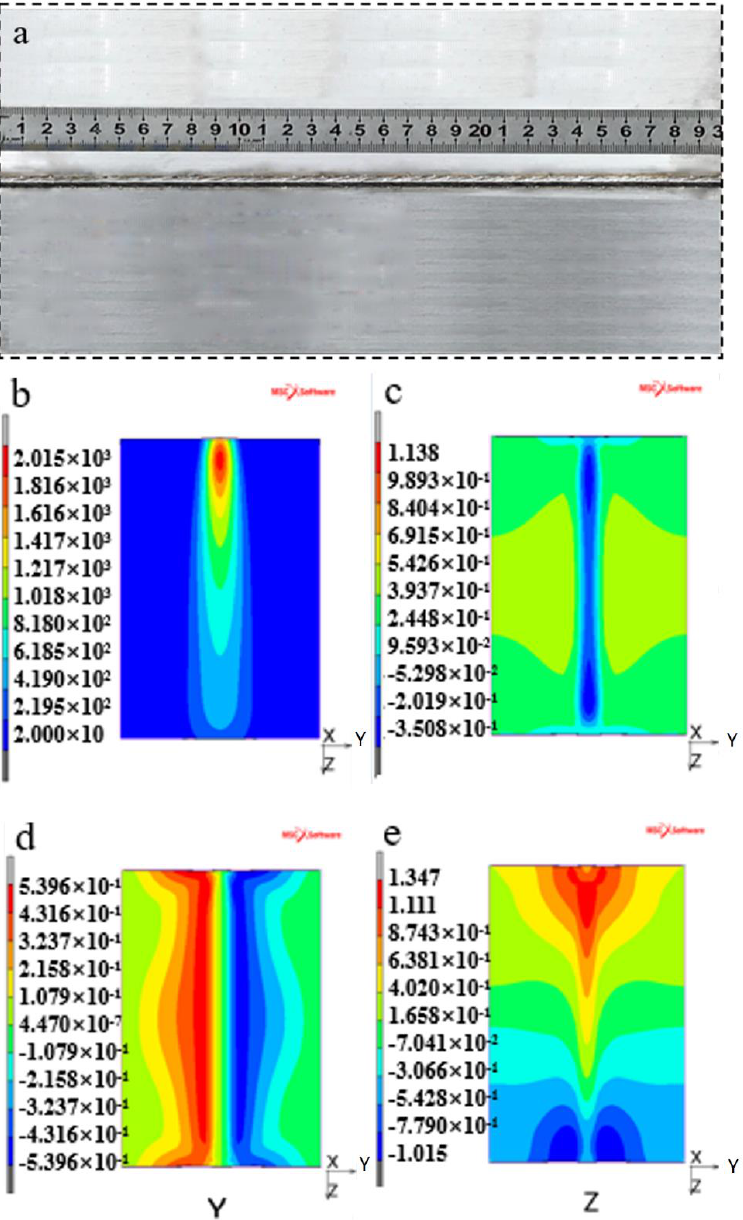
Figure 8. Heat source check. ( a ) heat source checking plate, ( b ) simulated welding temperature, ( c ) deformation in the X-direction, ( d ) deformation in the Y-direction, and ( e ) deformation in the Z- direction.